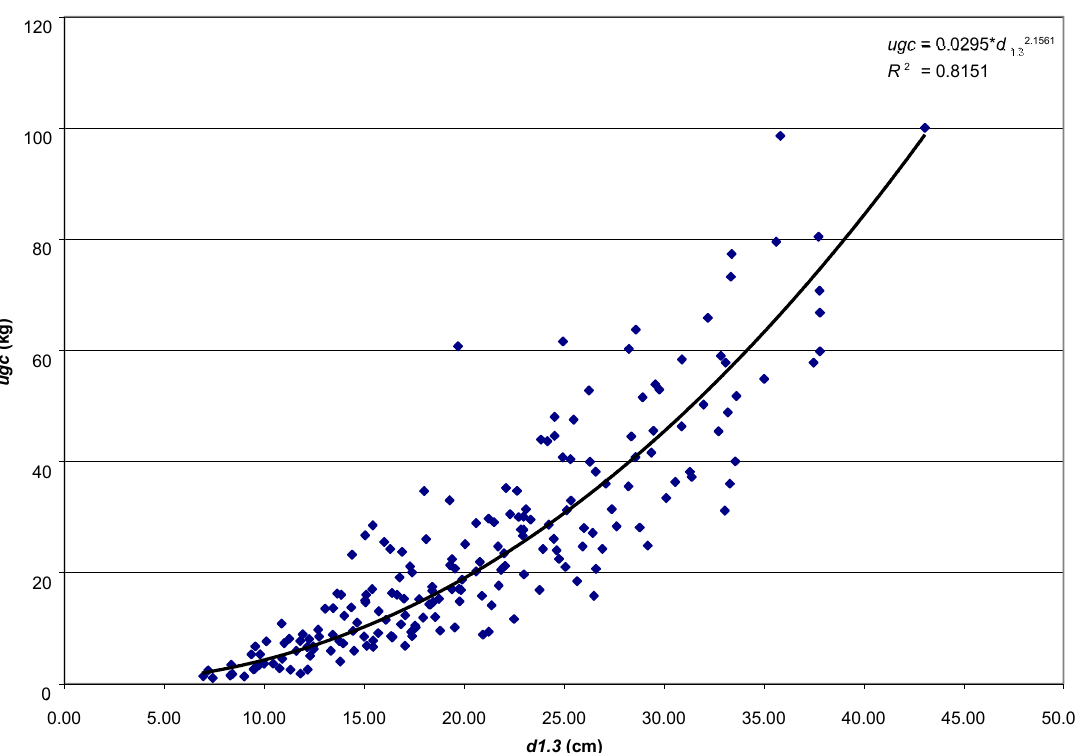
Figure 3. Dependence of weight of leaved twigs ( ugc ) on diameter at breast height ( d 1.3 ).